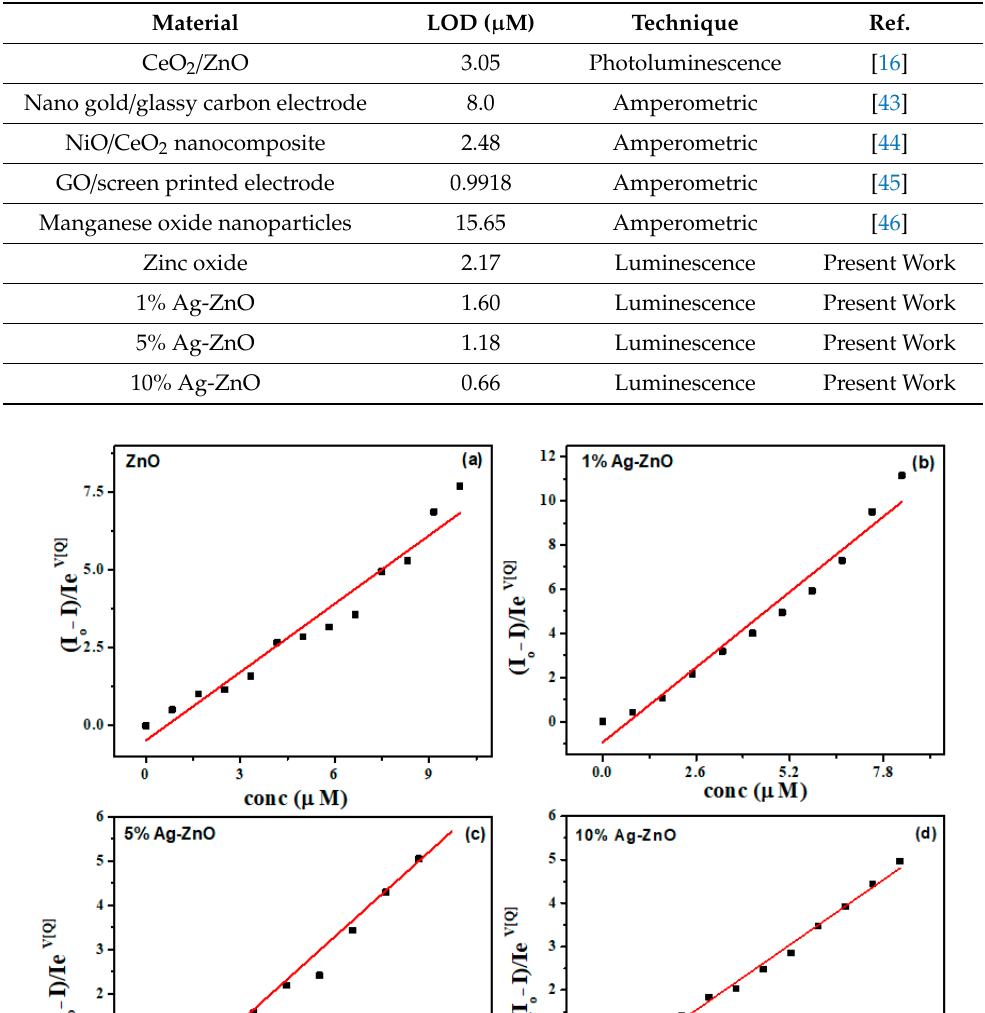
Table 2. Comparison of limits of detection (LODs) between synthesized Ag-ZnO nanostructures and various reported chemical sensors for PNP.